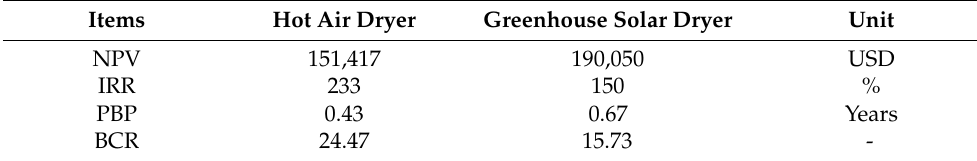
Table 4. Economic analysis of mango slices using hot air and greenhouse solar dryers.